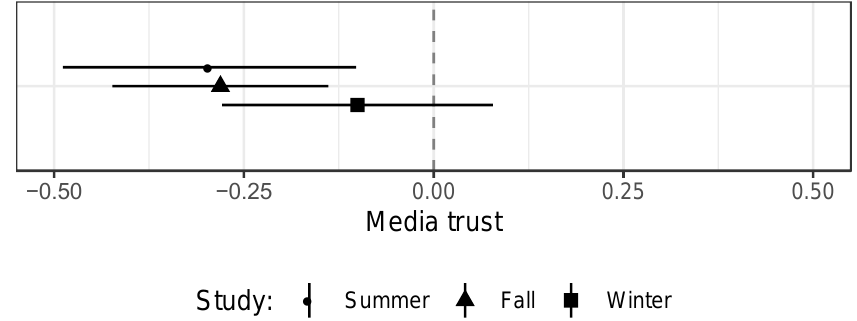
Figure 1a. Association between untrustworthy website consumption and media/party attitudes: Media trust. Change in media trust associated with consumption of untrustworthy websites. Point estimates (with 95% confidence intervals) from OLS regressions. Outcome measure is a four-point scale of self- reported trust and confidence in the mass media ranging from “None at all” (1) to “A great deal” (4). Control variables include partisanship, ideology, political knowledge, feelings toward Pre sident Trump, age, race, and college education. See Table B1 in Online Appendix B for full results.